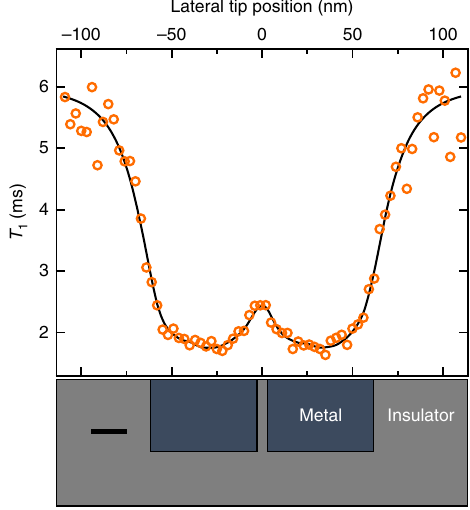
Fig. 4 Simulated NV T 1 line scan taken across a Mott insulator. The Mott insulator contains conducting pockets in an insulating material, as shown schematically at the bottom of the fi gure. The conducting regions, with σ = 3 × 10 3 Ω − 1 cm − 1 , are 40 × 40 × 60 nm 3 in size and are separated by 5 nm. Scale bar is 20 nm. The black curve is the theoretical T 1 and the orange circles represent a simulated measurement using spin-to-charge readout with 1 min of averaging per point. The NV-metal separation is 5 nm and the intrinsic NV T 1 is 6